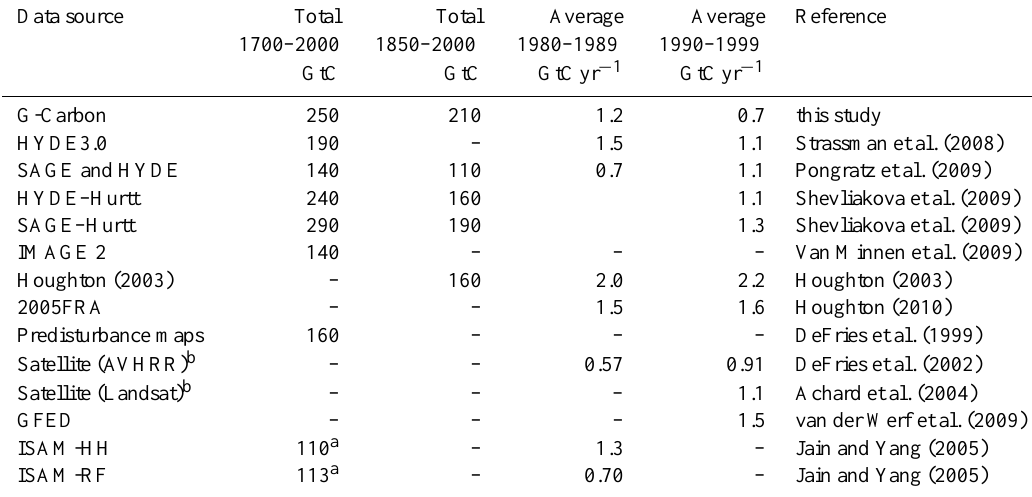
Table 5. Estimates of net land-use change emissions from other